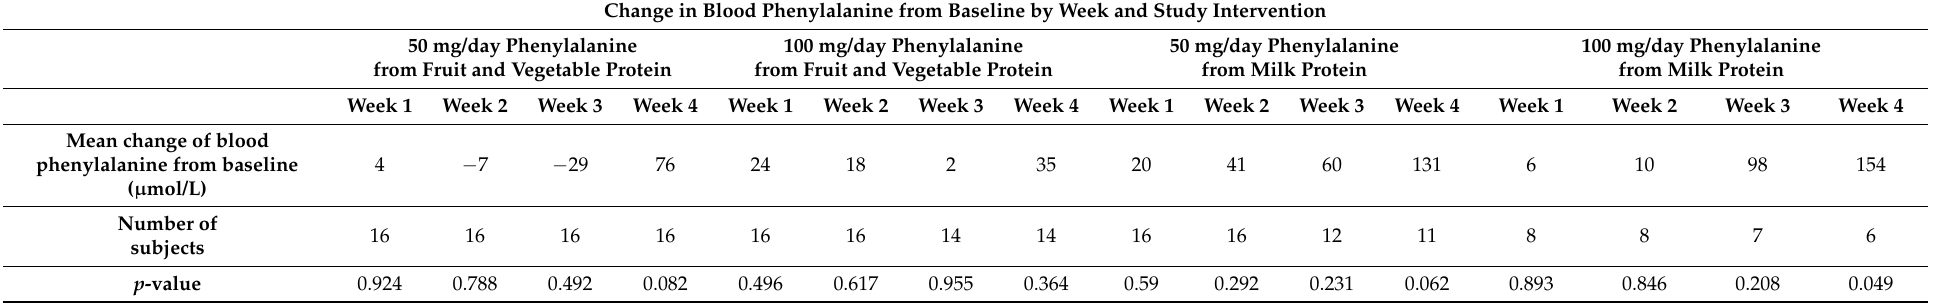
Table 5. Mean change in blood phenylalanine from baseline by week and study intervention. Change in Blood Phenylalanine from Baseline by Week and Study Intervention 50 mg/day Phenylalanine from Fruit and Vegetable